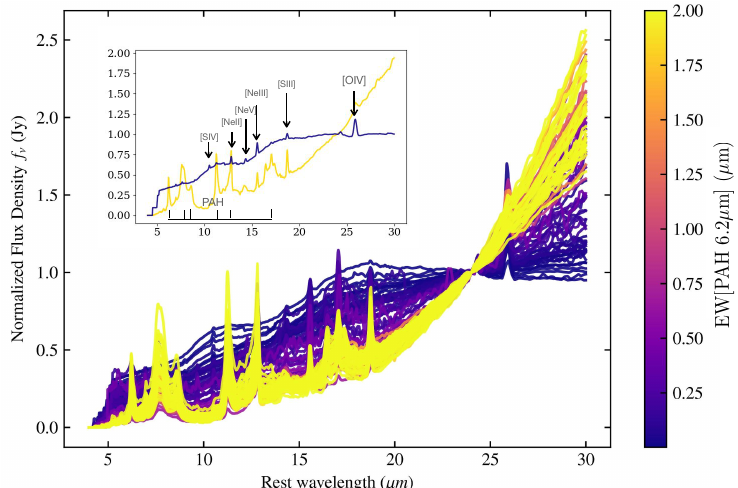
Figure 2. Stacked SEDs in bins of EW6.2 µ m where high EW galaxies are star-formation dom- inated, whereas low EW galaxies are AGN-dominated, at least in the mid-IR. The inset shows Figure5. Stacked Spitzer spectrabinnedbyEQW[PAH6.2 µ m]:wesplitoursampleinto100evenlypopulatedbinsofEQW[PAH6.2 µ m].Wenormalizeeach pre-stackedindividualspectrumbyitsIRS f ⌫ [24 µ m].Weusetheblue-to-yellowgradientcolormapthroughoutthisworktoindicatetheEQW[PAH6.2 µ m], just two representative templates, one high EW6.2 µ m (this looks much like the stacked SED of withbluecorrespondingtoAGN-dominatedandyellowSF-dominated.Theinsetshowsonlytwospectrafromthestacks,alowEQW(blue)andhighEQW (yellow)stack,andismeanttoprovideaneasycomparisonbetweenthestacks.WeprovidetheentiretyofthestackedspectrainASCIIformatintheon-line local pure starburst galaxies [61]) and one low EW6.2 µ m (this appears very similar to the SED versionofthispublication. of an unobscured/Type 1 AGN (e.g., [18,51]), see also Figure1c. Among IR galaxies, we see a continuum of equivalent widths corresponding to a continuum of AGN fractions. Besides the equiv- than 0 . 54 µ m, then we classify the object as SF dominated. Sub- section 2.8 visually demonstrates that the PAH 6.2 µ m feature ef- alent width, it is clear that star-forming galaxies have steeper 30 µ m/15 µ m slopes. Adapted from fectivelydi ↵ erentiatesbetweenAGNandSFdominatedMIRspec- tra: when we select AGN dominated targets on the basis of their Lambrides et al. [69], with permission from the EQW[PAH 6.2 µ m] we also find them to be AGN dominated on the basis of their continuum slopes between 15 to 30 µ m. Using theEQW[PAH6.2 µ m]selectionmethodwefind:40percentAGN